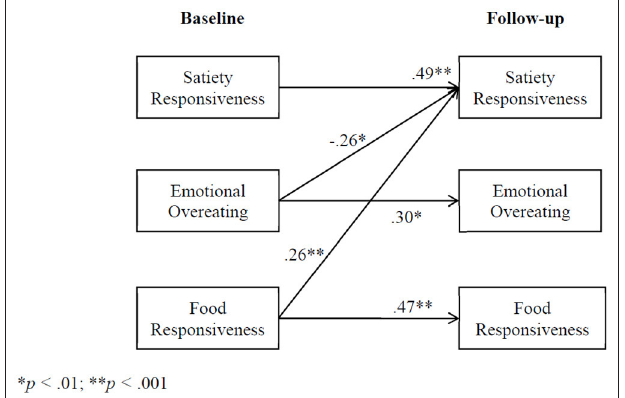
FIGURE 2 | Cross-lagged panel analysis: child appetitive traits to child appetitive traits (unstandardized B weights). * p < 0.01; ** p < 0.001.